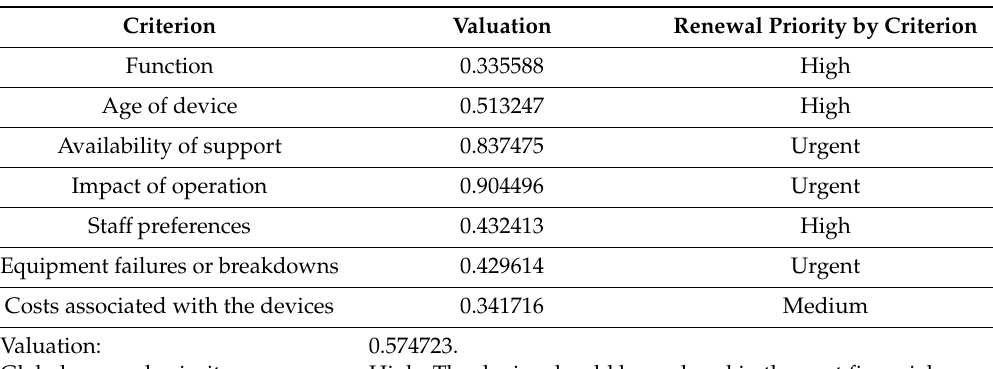
Table 24. Results for the X-ray surgical C-arm device.